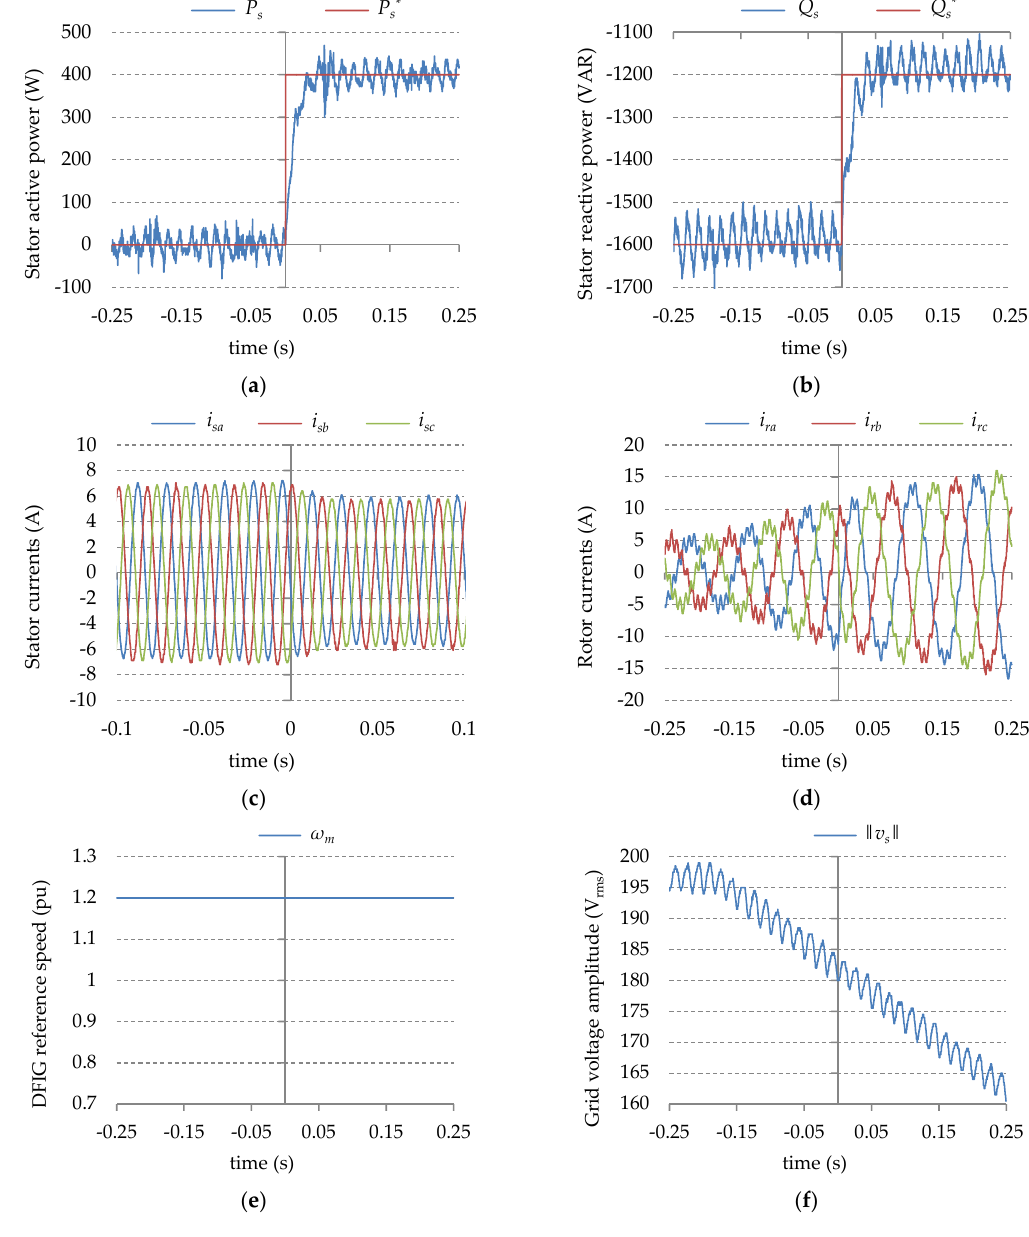
Figure 15. Experimental results for the effect of variation of the grid voltage amplitude on the proposed decoupled control: ( a ) stator active power; ( b ) stator reactive power; ( c ) stator currents; ( d ) rotor currents; ( e ) DFIG’s reference speed; ( f ) stator (grid) voltage amplitude.